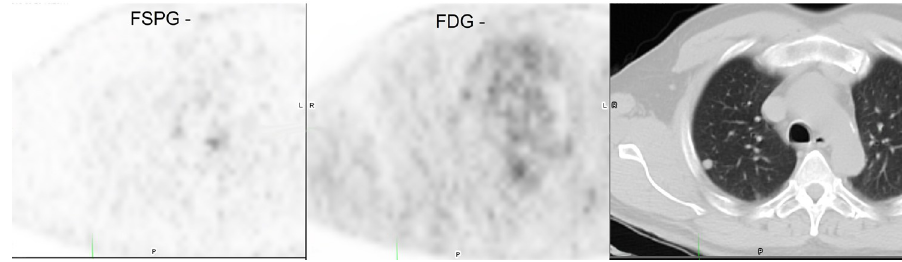
Fig 4. Subject with negative 18 F-FSPG (SUVmax 0.4) and 18 F-FDG (SUVmax 0.54) PET/CT.